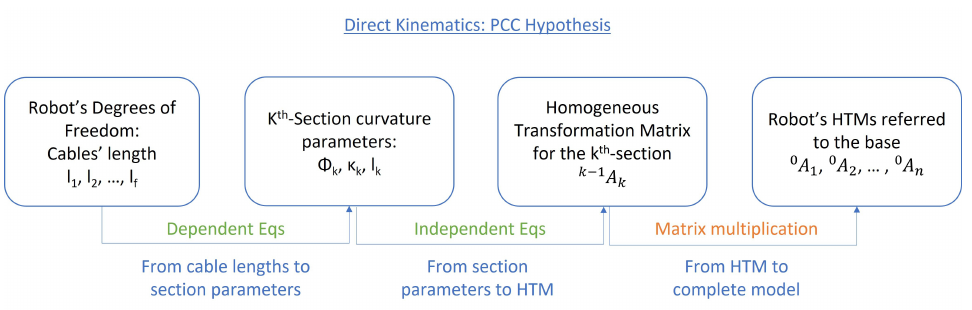
Figure 7. Direct kinematics for